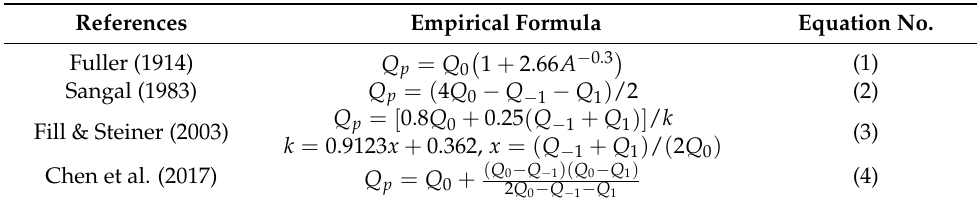
Table 2. Empirical formulas for estimating the instantaneous peak flow (IPF) from the mean daily flows